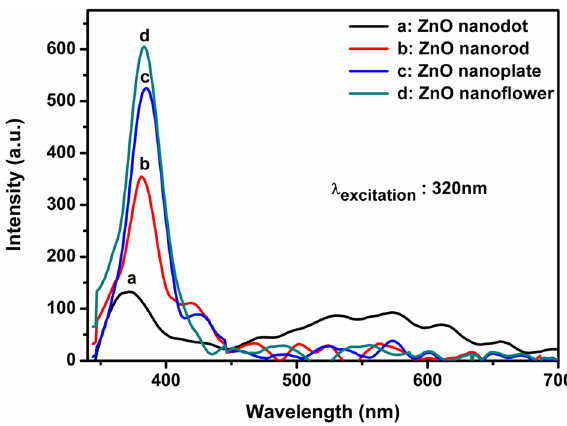
Figure 7. PL emission spectra of ZnO nanostructures synthesized in distinct solvents.